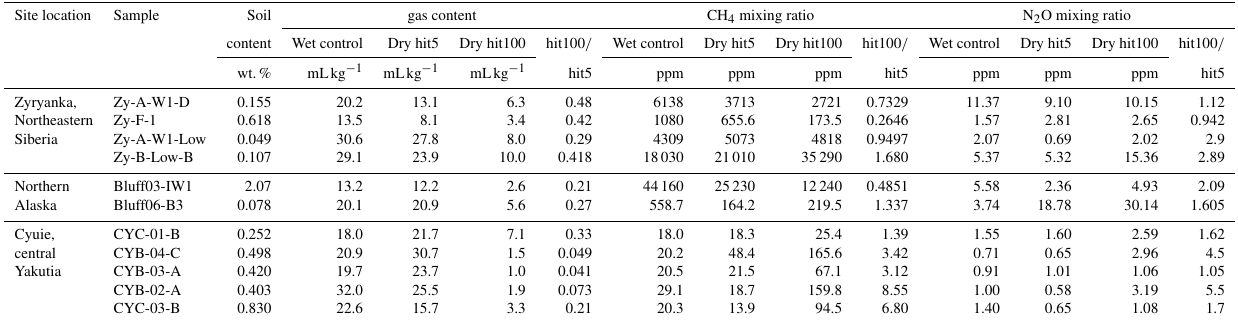
Table A1. Results of dry extraction tests with 5 and an additional 100 hits to the ice-wedge samples, denoted as “hit5” and “hit100”, respectively. “hit100 / hit5” is the ratio in extracted gas content or gas mixing ratio of the hit100 to hit5 cases. Also shown are gas content results from both experiments, where the hit100 values are given in units of millilitre per kilogram (mLkg − 1 ) at STP conditions. It should be noted that the hit100 gas content results indicate the additional amount of gas extracted after hit5 crushing and evacuation. Site location Sample